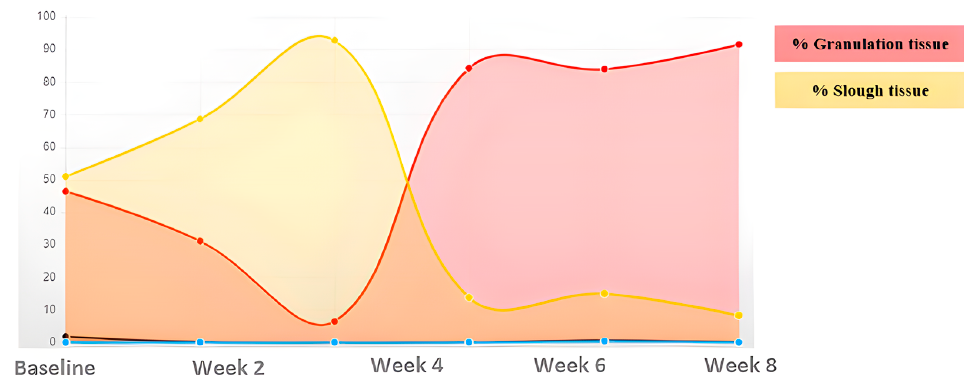
Figure 11. Healing evolution case 6: Baseline assessment ( left ), Baseline HELCOS analysis ( centre ), Week 13 assessment ( right ).